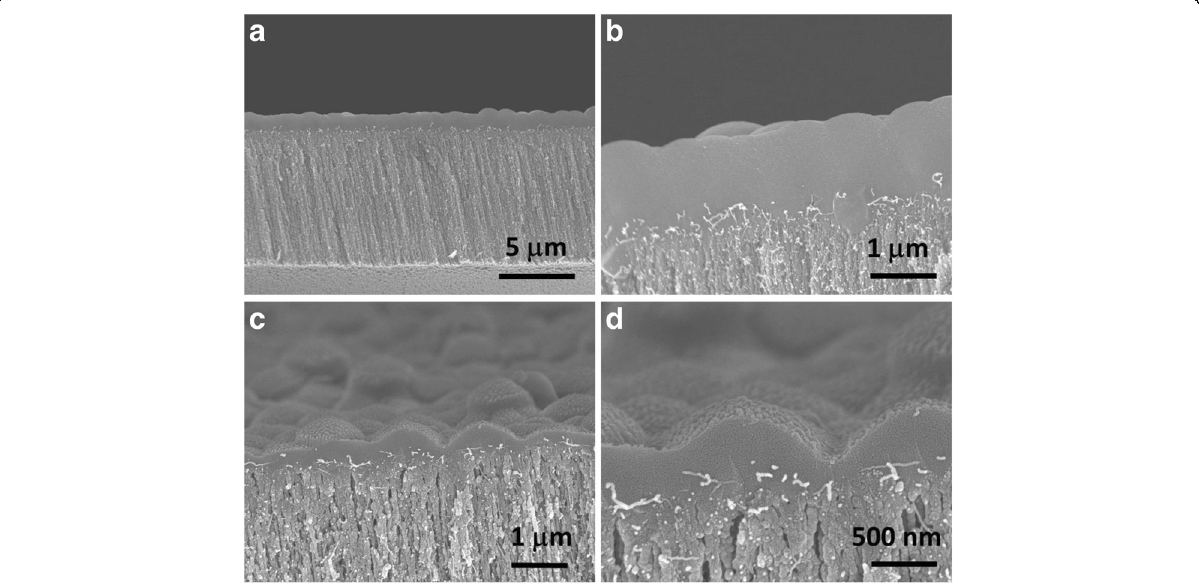
Fig. 5 Cross-sectional SEM images of CNT-SiN x membranes. a Low- and b high-magnification images of a CNT membrane before opening the CNT pores with etching steps and, thus, before ion rejection studies. c Low- and d high-magnification images of the top surface of a CNT membrane after etching and after ion filtration studies. In all images, a dense SiN x layer on the membrane surface and the vertical alignments of the CNTs in the composite are clearly visible. After etching, CNT bundles emerge from the membrane top